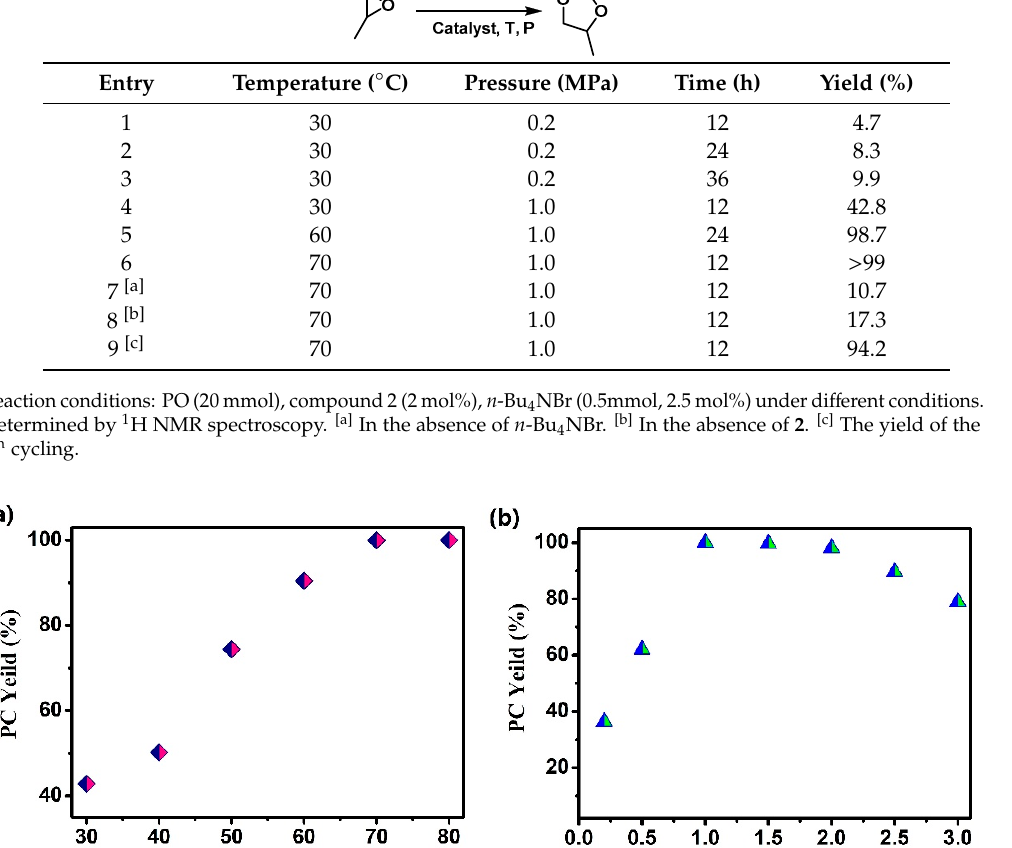
Table 1. Cyclo-addition of CO 2 with propylene oxide under different reaction conditions.